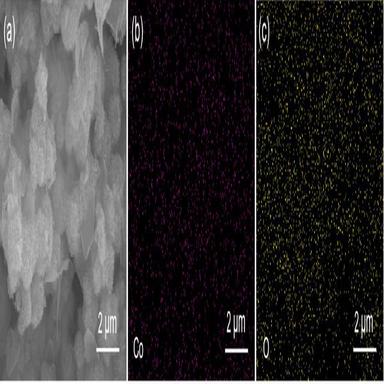
(a) SEM images of β-Co(OH)2 microflowers, and the related EDS elemental mappings of (b) cobalt as well as (c) oxygen.